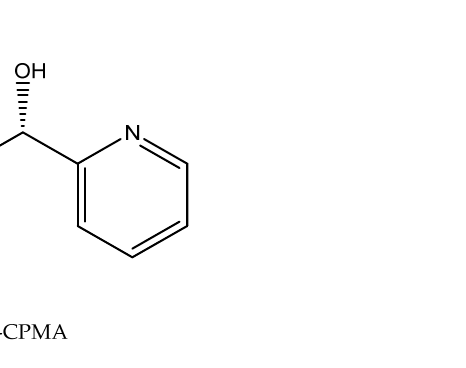
Figure 6. Structure of ( S )-CPMA. Reprinted from [65] with permission; copyright Elsevier B.V. 2017. Addition (at 10% v / v ) of a hydrophilic ionic liquid such as 1-(2 (cid:48) -hydroxyl)ethyl-3- methylimidazolium nitrate has been effectively undertaken in the bioreduction of several aryl ketones and demonstrated high biocompatibility and increased the permeability of the cell membranes, which facilitated the reaction course. All the tested ketones, which had different substituents, were reduced with Acetobacter sp. to the corresponding R -alcohol with anti-Prelog enantiotopic selectivity and mostly with high enantiomeric excesses of up to 99% [66]. Additionally, as in the previously discussed case (see Section 5), the course of the bioreduction process was facilitated both by the type of substituent (electron- withdrawing groups, such as -NO 2 or halogen) and its location in the aromatic ring ( ortho position)